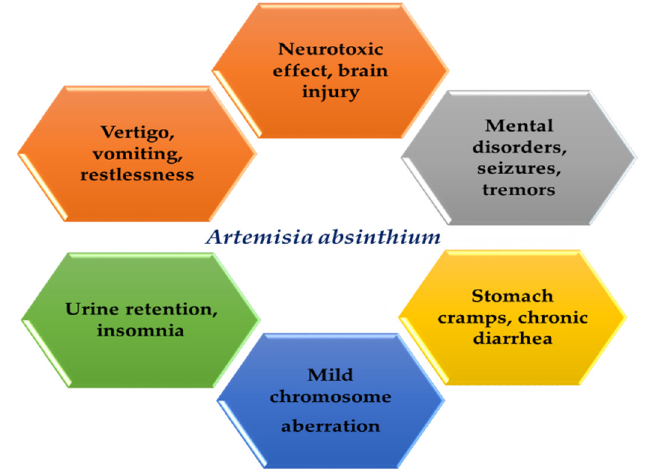
Figure 3. Schematic representation of different side effects of A. absinthium and its related compounds.